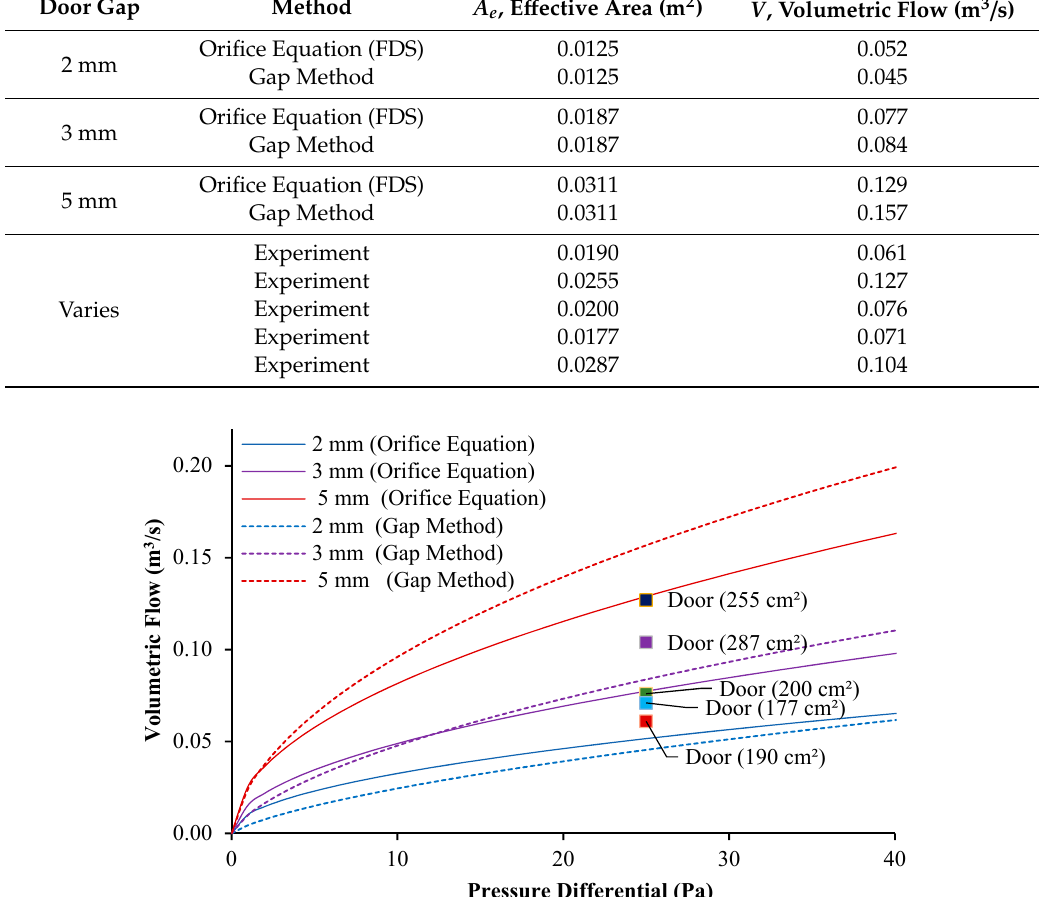
Figure 5. Airflow through closed doors from the orifice equation, gap method, and experimental measurements.